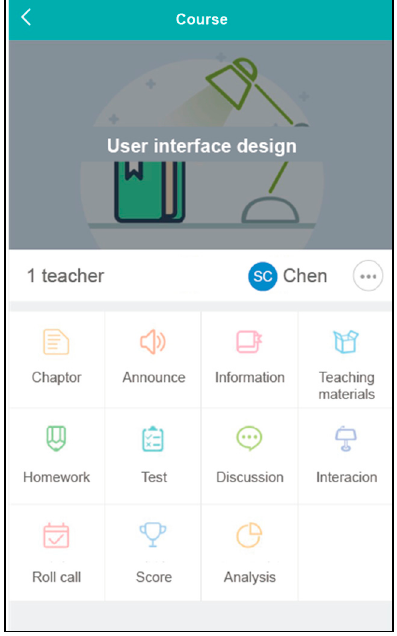
Figure 7. Promising experimental sample B.